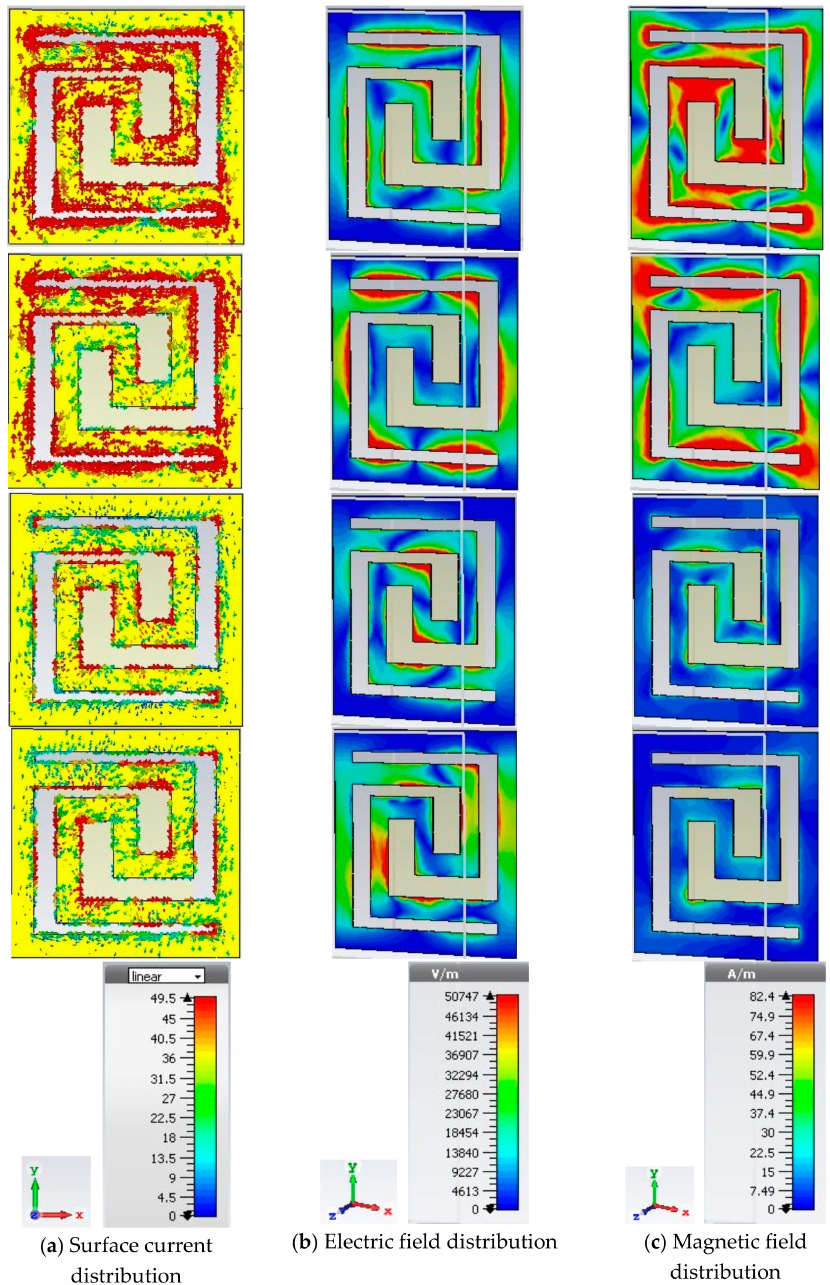
Figure 10. Instantaneous distribution of ( a ) surface current, ( b ) electric field, and ( c ) magnetic field at 15.04, 22.17, 25.46, and 26.88 GHz, respectively, for Rogers 4003